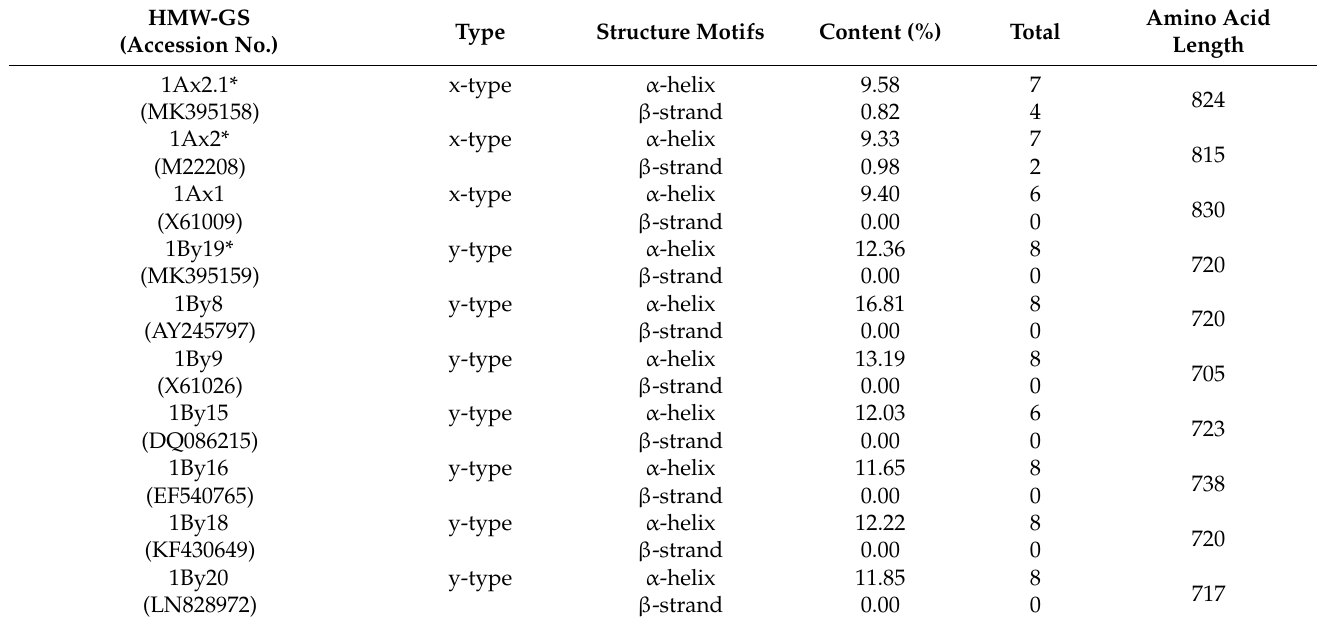
Table 3. Secondary structure prediction of 1Ax2.1* and 1By19* subunits and other eight wheat